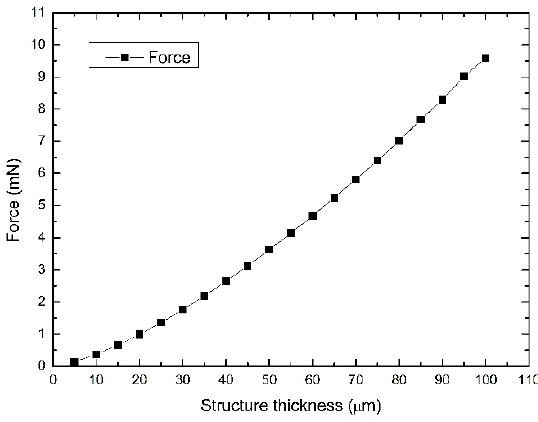
Figure 9. Voltage vs. displacement and force at a jaw of initial microgripper.